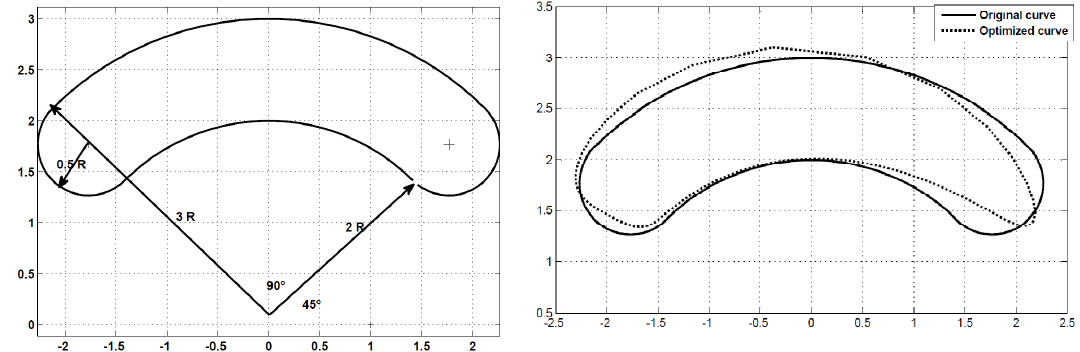
Figure 5. Example 3. (Left panel) The original curve, and (right panel) the original and the final curves compared.